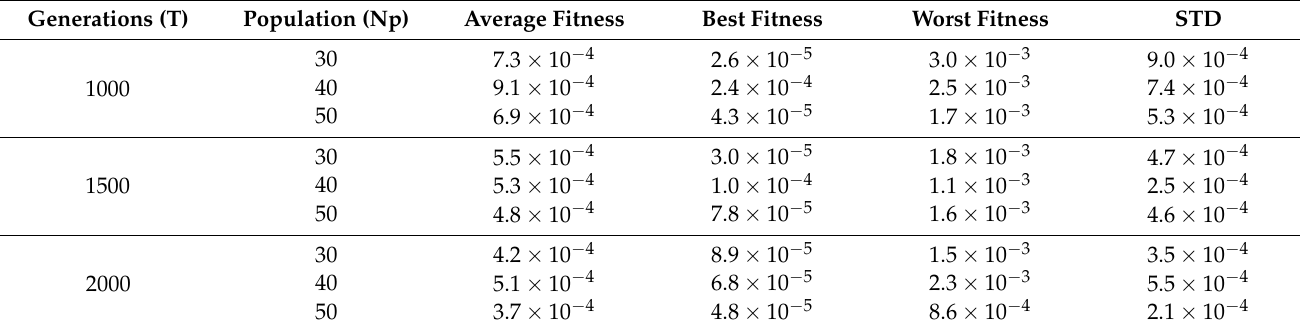
Table 9. AO parameter analysis for case